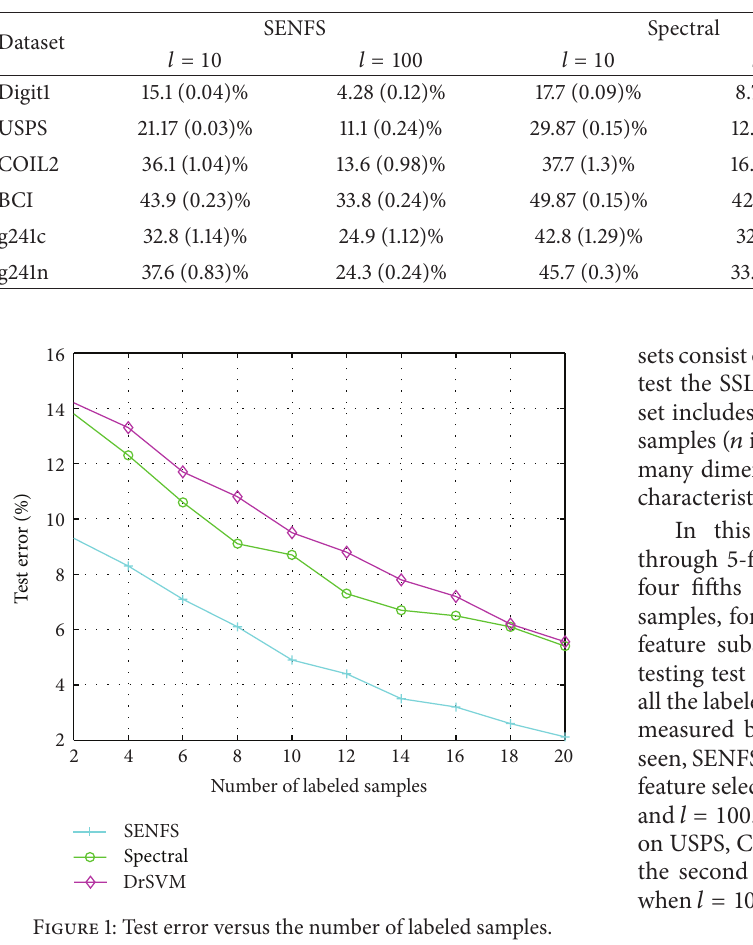
DrSVM. The supervised feature selection method